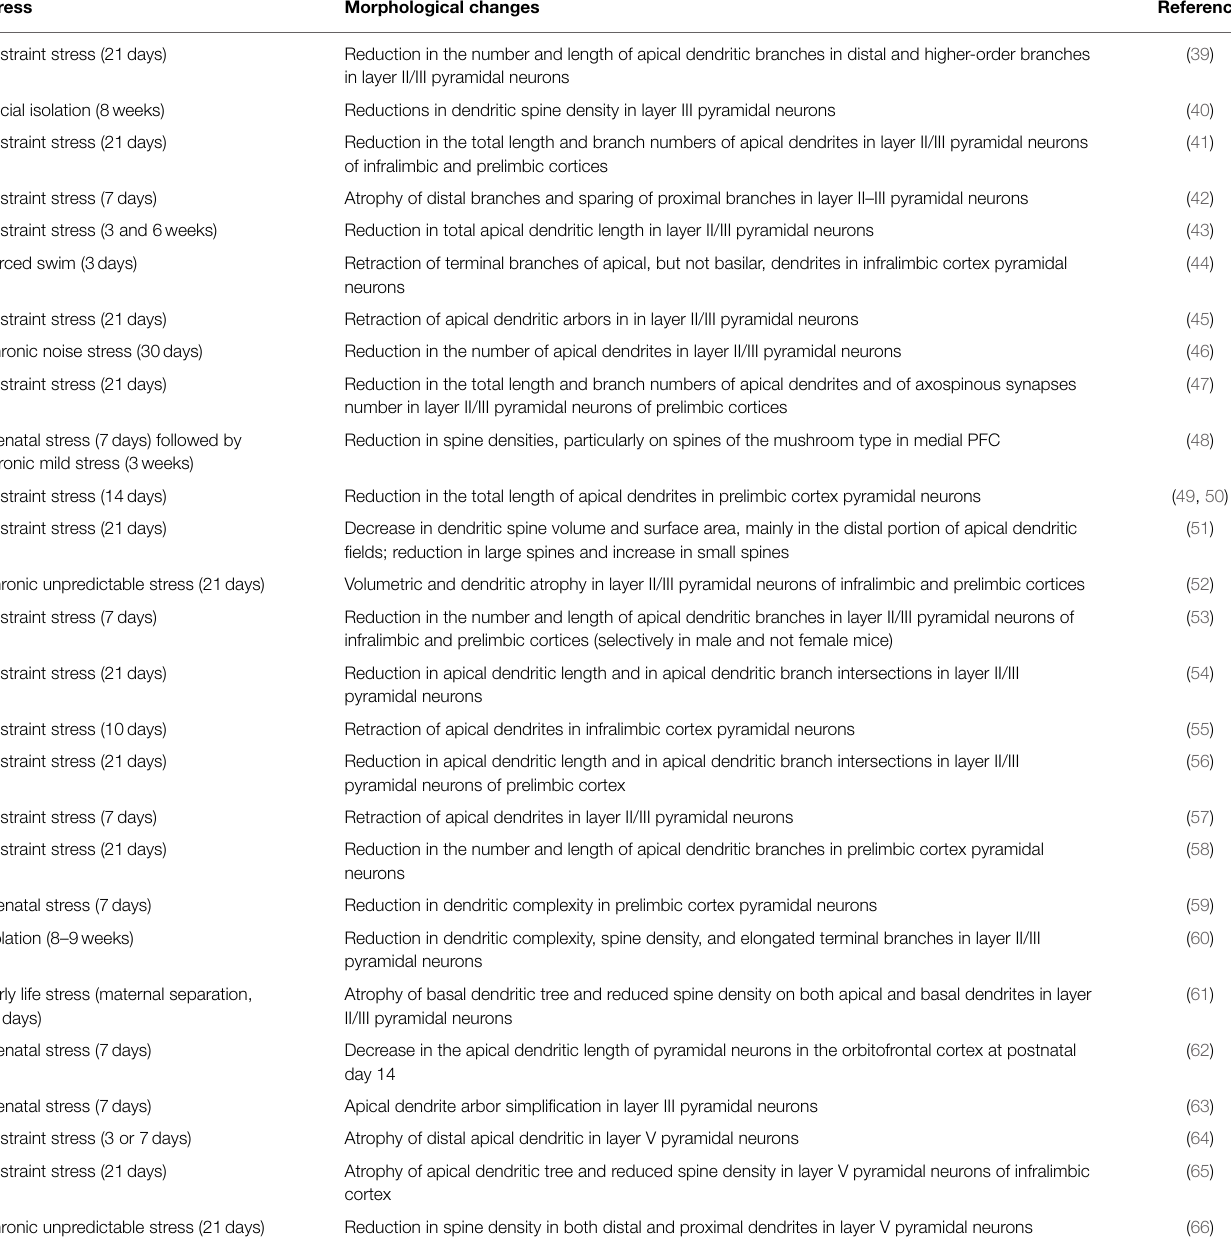
TABLE 1 | Effect of chronic stress on neuronal remodeling in the prefrontal cortex: animal studies . Stress Morphological changes